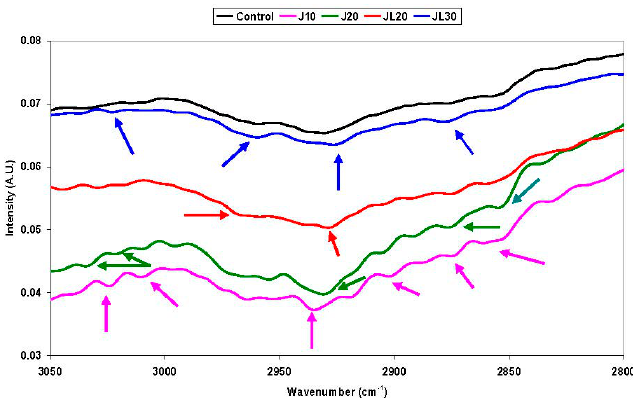
Figure 8. FTIR spectra in second derivative mode showing the increased lipid disorder by the band shifts of the lipid acyl –CH 2 bands in samples exposed to As in June and July. This FTIR plot includes all the samples considered in the study. As a qualitative case, the average and standardized spectrum of each sample was considered. “J10” and “J20” are June samples treated with As 10 and 20 g·L − 1 , respectively. “JL10” and “JL20” are July samples treated with As 10 and 30 g·L − 1 , respectively. The arrows (with the same colour of the sample) show the ranges where the band shape changes are more relevant with respect to the control samples.